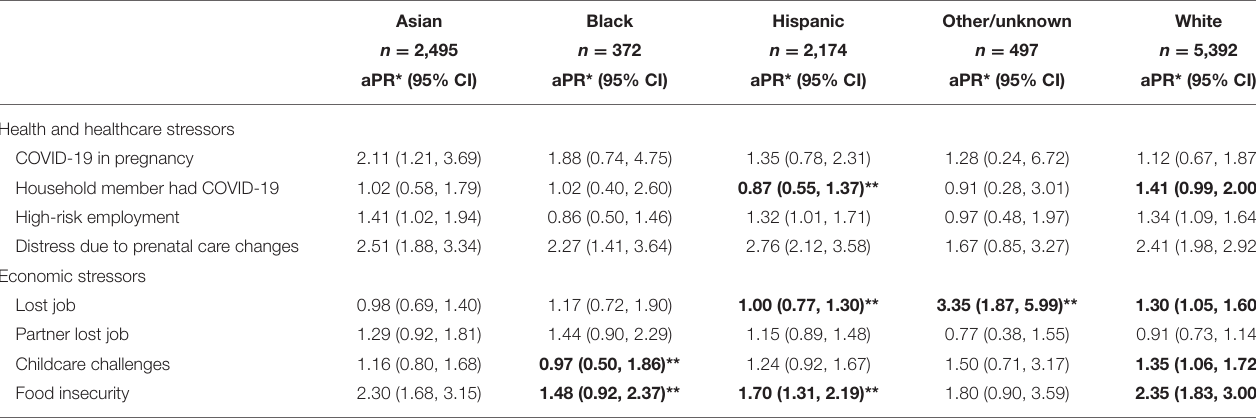
TABLE 3A | Adjusted prevalence ratio (aPR) for the relationship between COVID-19-related health/healthcare and economic stressors and prenatal depression, stratified by racial and ethnic category. Asian